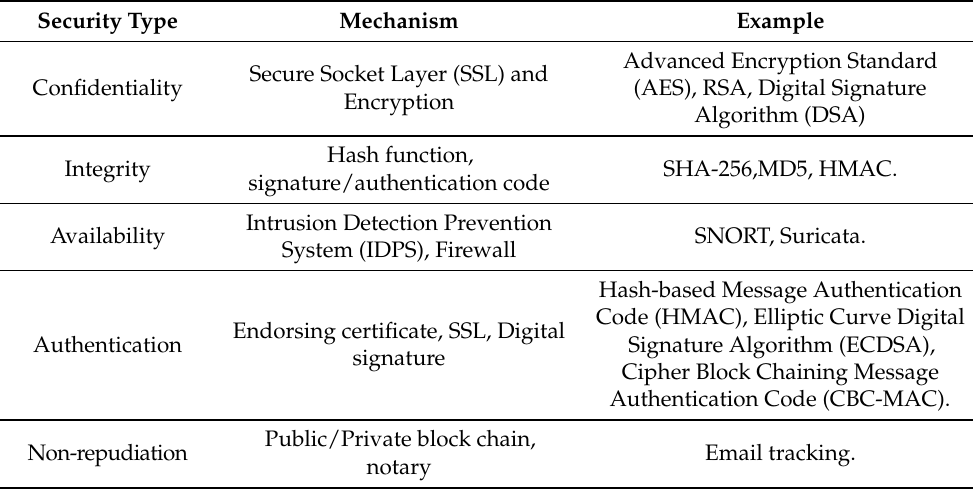
Table 5. Security type with respect to mechanism, with example.